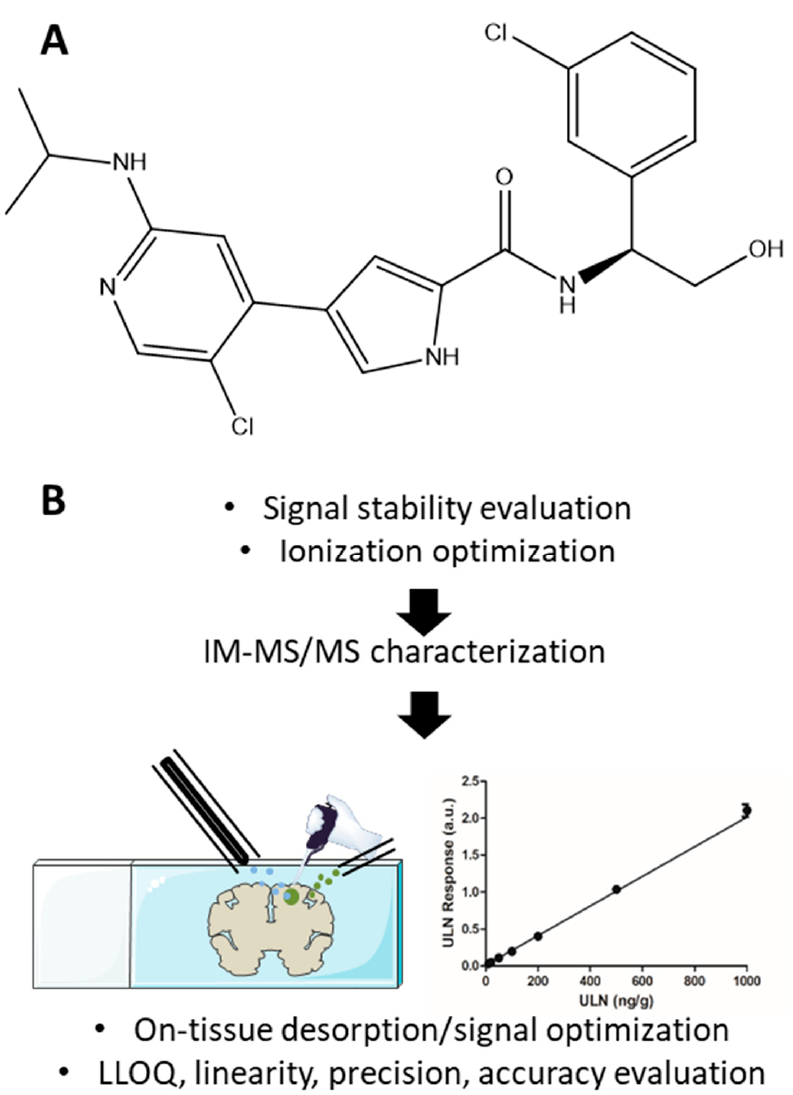
Figure 1. ( A ) Chemical structure of ulixertinib. ( B ) Steps for analytical performance evaluation.